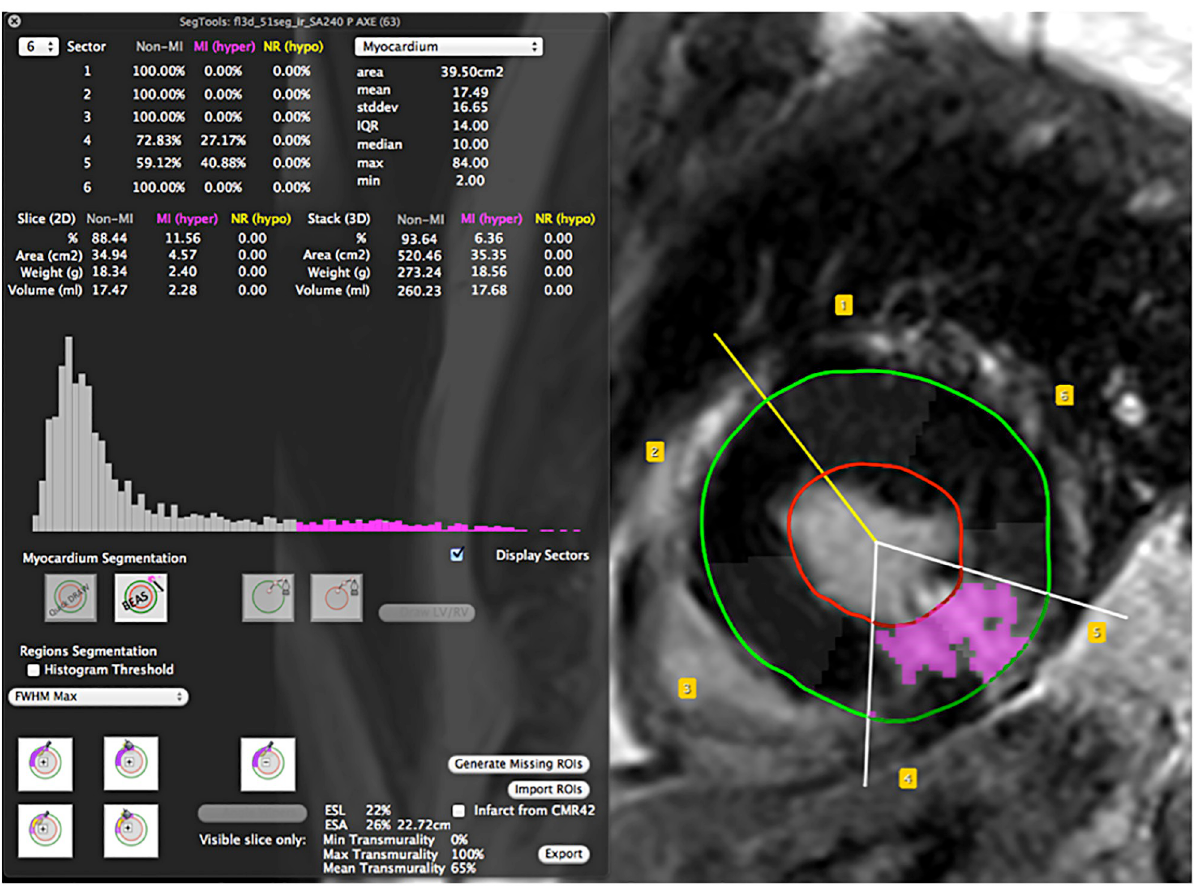
Fig 2. CMRSegTools workspace. The CMRSegTools GUI (left) shows the histogram highlighting the bins matching the lesion segmentation. The user can select the algorithms for the segmentation of the myocardium or some of its regions. The image viewer (right) displays the segmented area in magenta as well as the Epicardium (green) and Endocardium (red) contours, LV/RV junction landmark (yellow segment) and AHA region segments. The LGE image presented was obtained with a 3D IR GRE